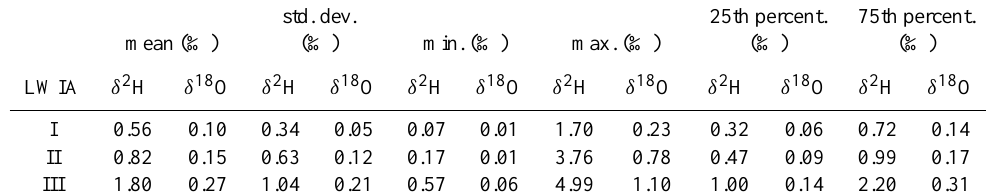
Table 4. Basic descriptive statistics of standard deviation values of δ 2 H and δ 18 O measurements. std. dev.